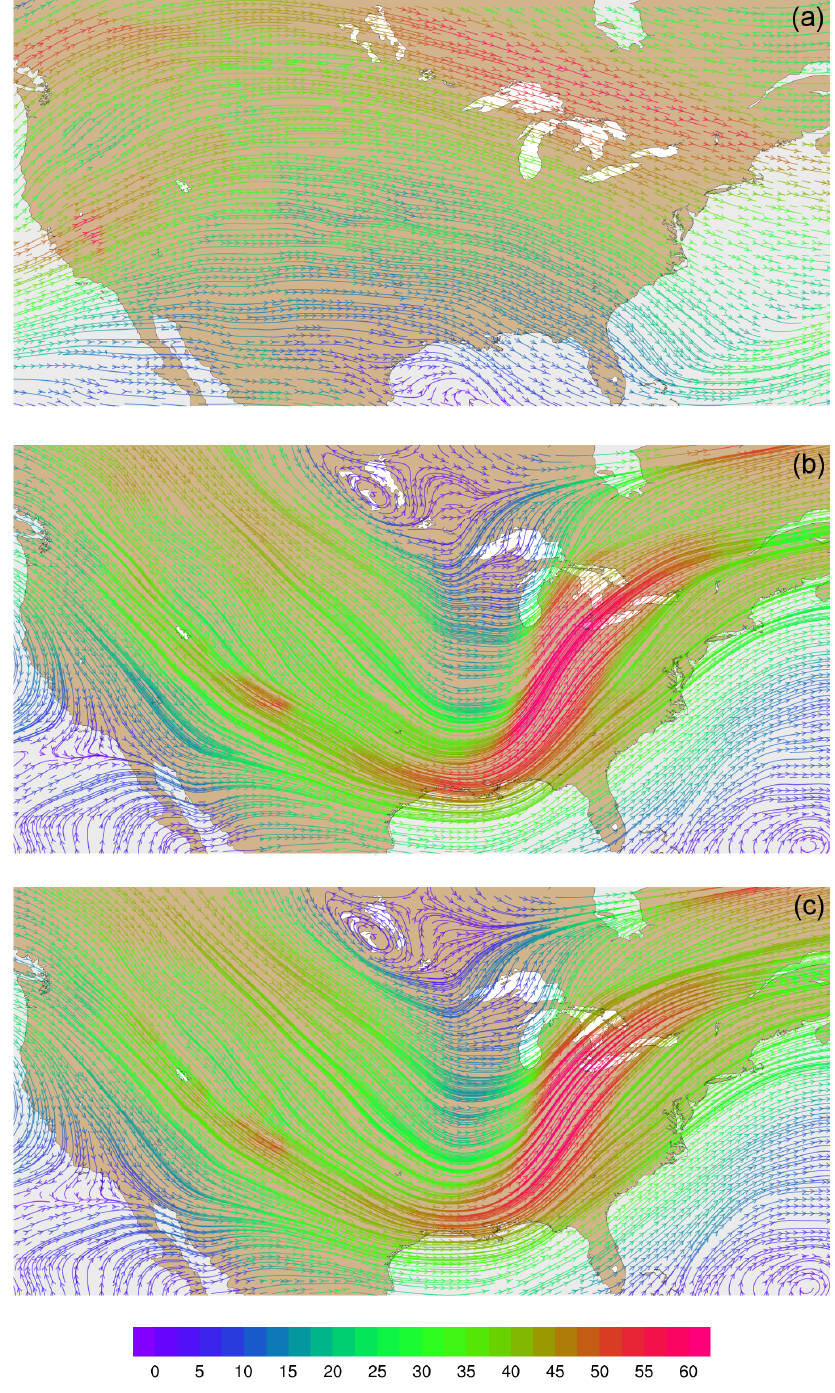
Figure 10. Streamline analyses for layer 28 ( ∼ 500–300hPa) at 00:00UTC on 31 January 2013 focused on the contiguous United States (a) from MPAS-A without FDDA, (b) FDDA target field, and (c) MPAS-A using FDDA. Streamline color indicates wind speed (ms − 1 )